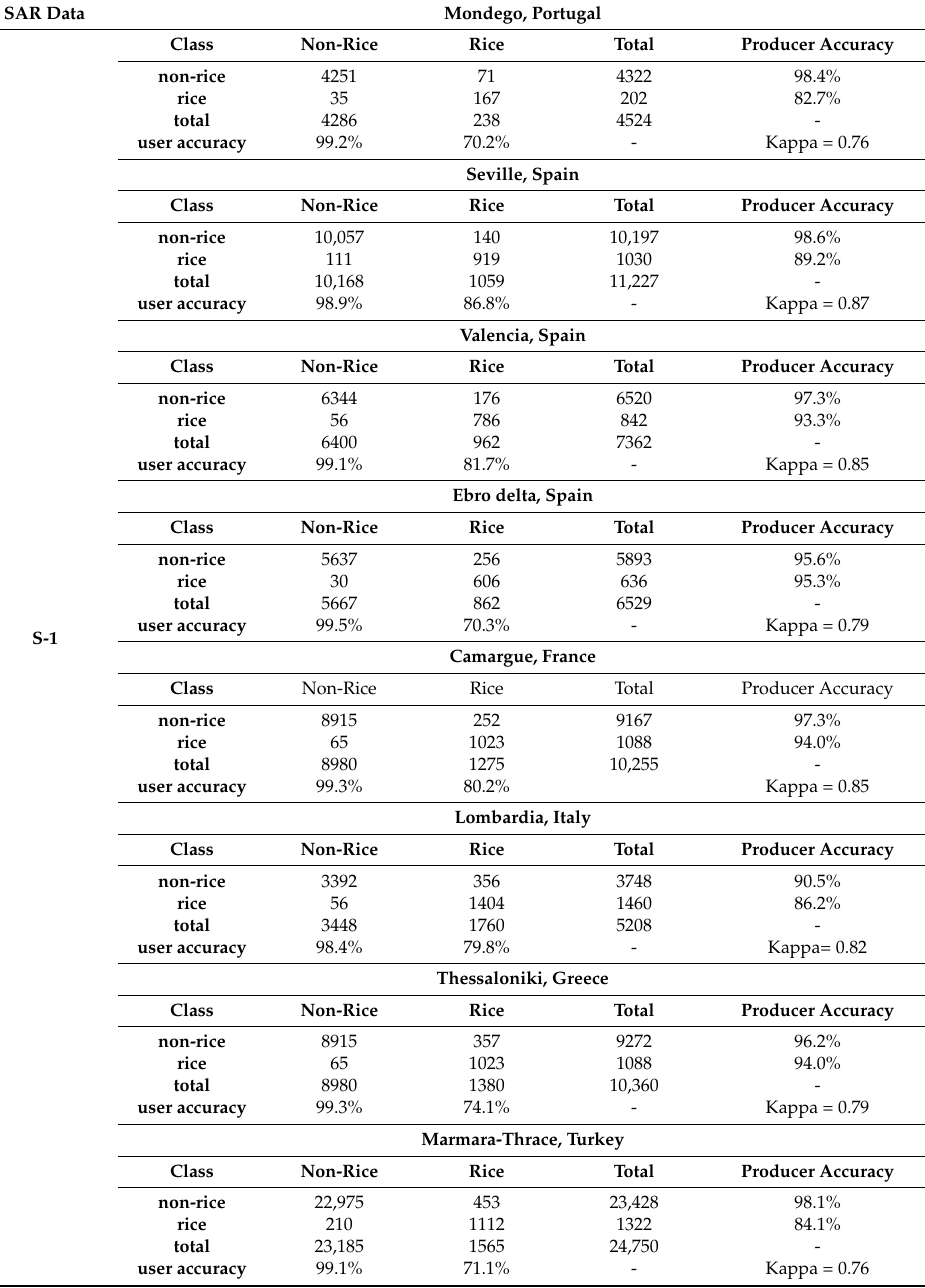
Table 2. Confusion matrices of the accuracy